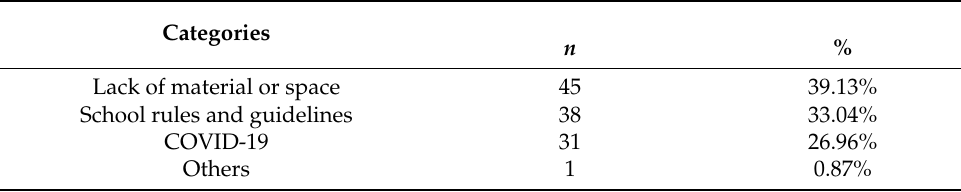
Table A4. Reasons for restrictions in recess.